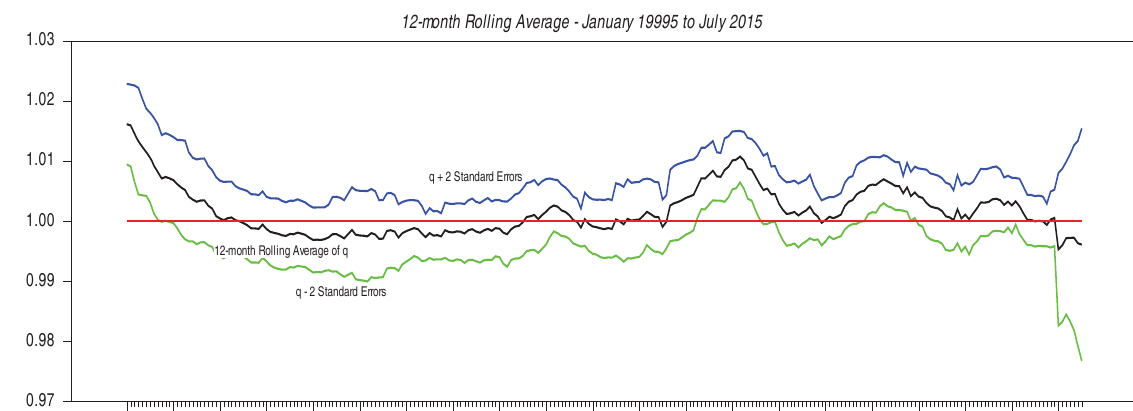
Fig. 8. Chinese yuan-U.S. dollar real exchange rate